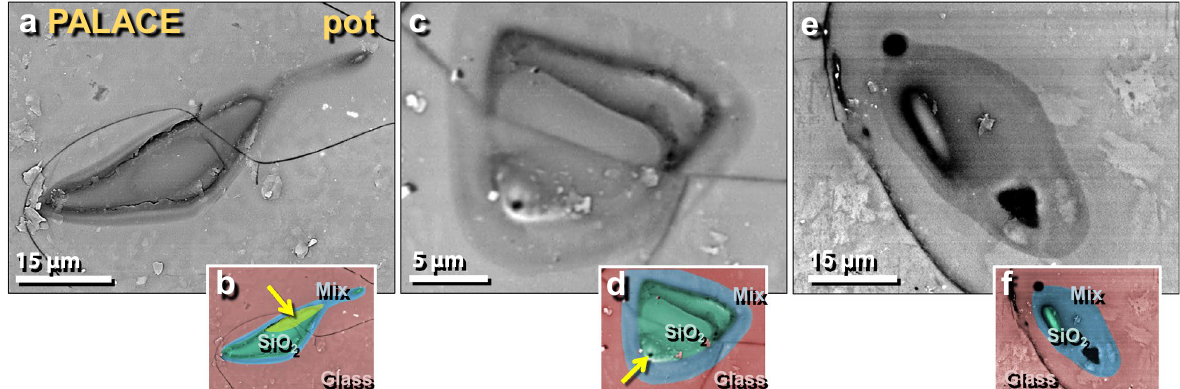
Figure 22. SEM images of melted quartz grains on melted potsherd from the palace. ( a ) Highly melted quartz grain from the upper surface of melted pottery; shows flow lines of molten quartz in darker ‘neck’ at upper right; ( b ) manually constructed EDS-based phase map showing 100% quartz grain (green) embedded in Ca–Al–Si matrix of melted pottery (red); blue marks mixing zone between SiO 2 and matrix at approximately > 1713 °C, the melting point of quartz. Yellow arrow points to area depleted in oxygen, indicating high-temperature transformation to elemental Si mixed with melted SiO 2 . ( c ) Highly melted quartz grain; ( d ) manually constructed EDS-based phase map showing diffusion/mixing zone in blue with arrow pointing to bubble, indicating outgassing as grain reached temperatures above its melting point. ( e ) Quartz grain that has almost completely melted; ( f ) manually constructed EDS-based phase map showing the small remnant of a melted quartz grain (green) with a wide mixing zone (blue).